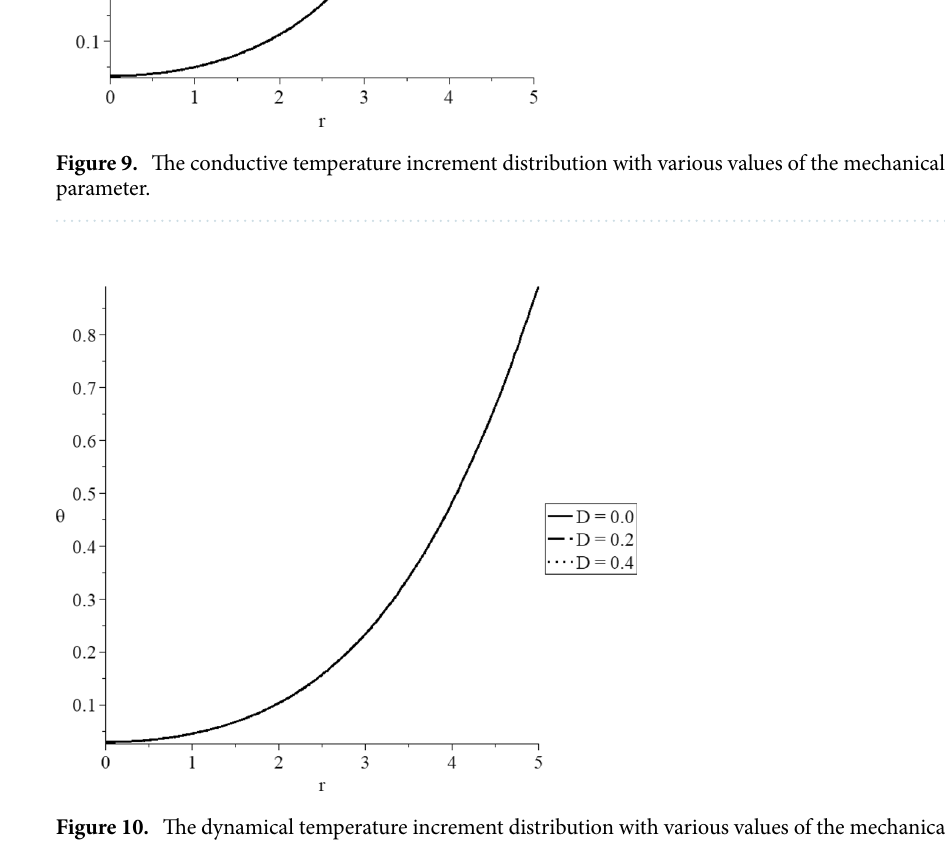
Figure 10. The dynamical temperature increment distribution with various values of the mechanical damage